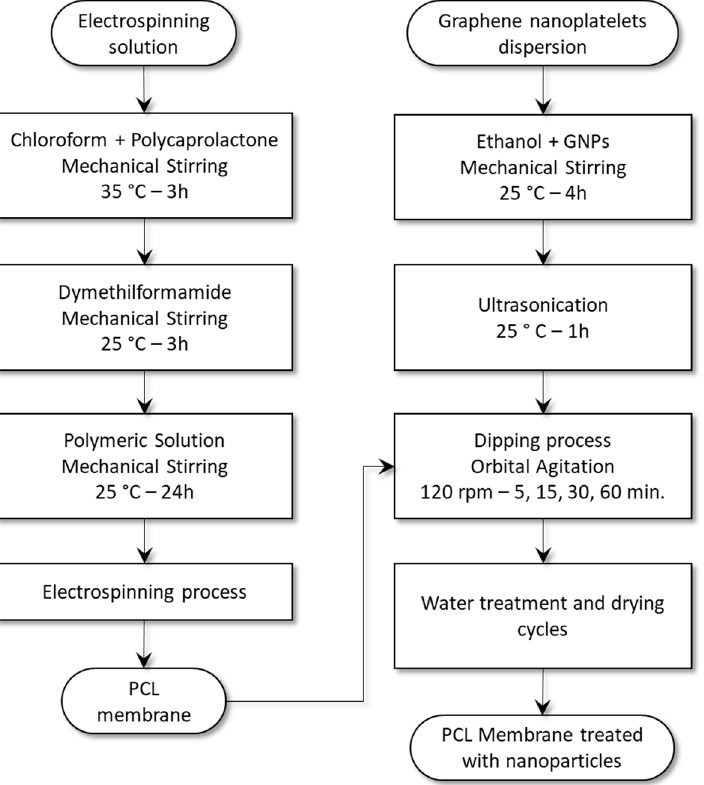
Figure 1. Schematic flow chart of the graphene nanoplatelets (GNPs)- polycaprolactone (PCL) membranes preparation.